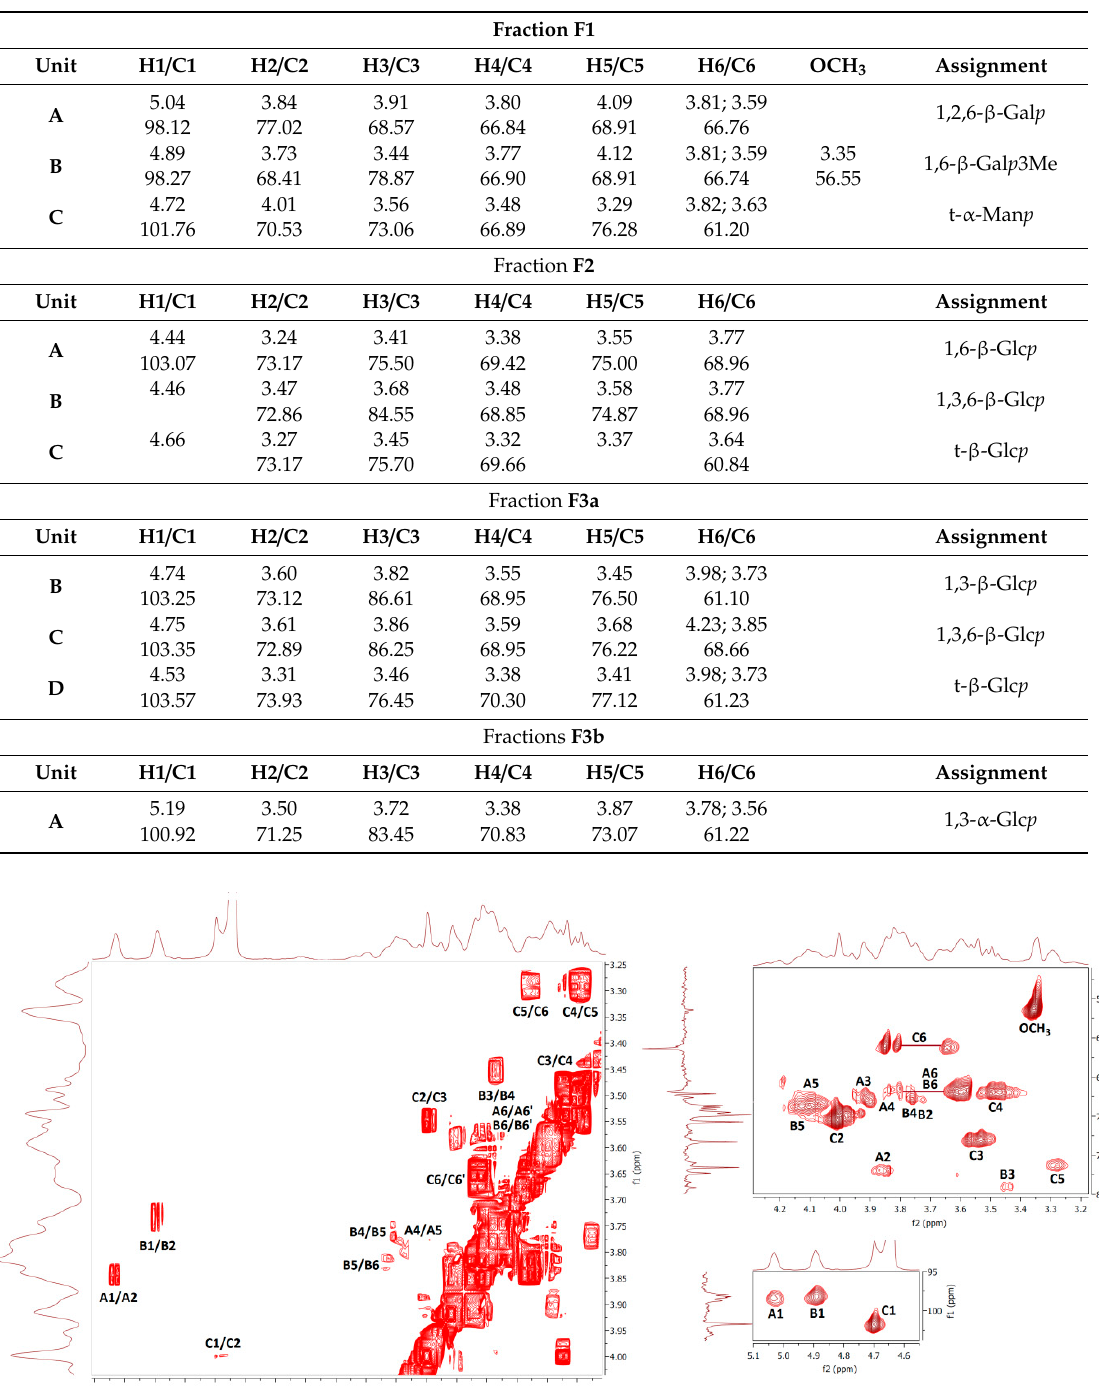
Table 5. Proton and 13 C resonance signal assignments for the polysaccharidic fractions.